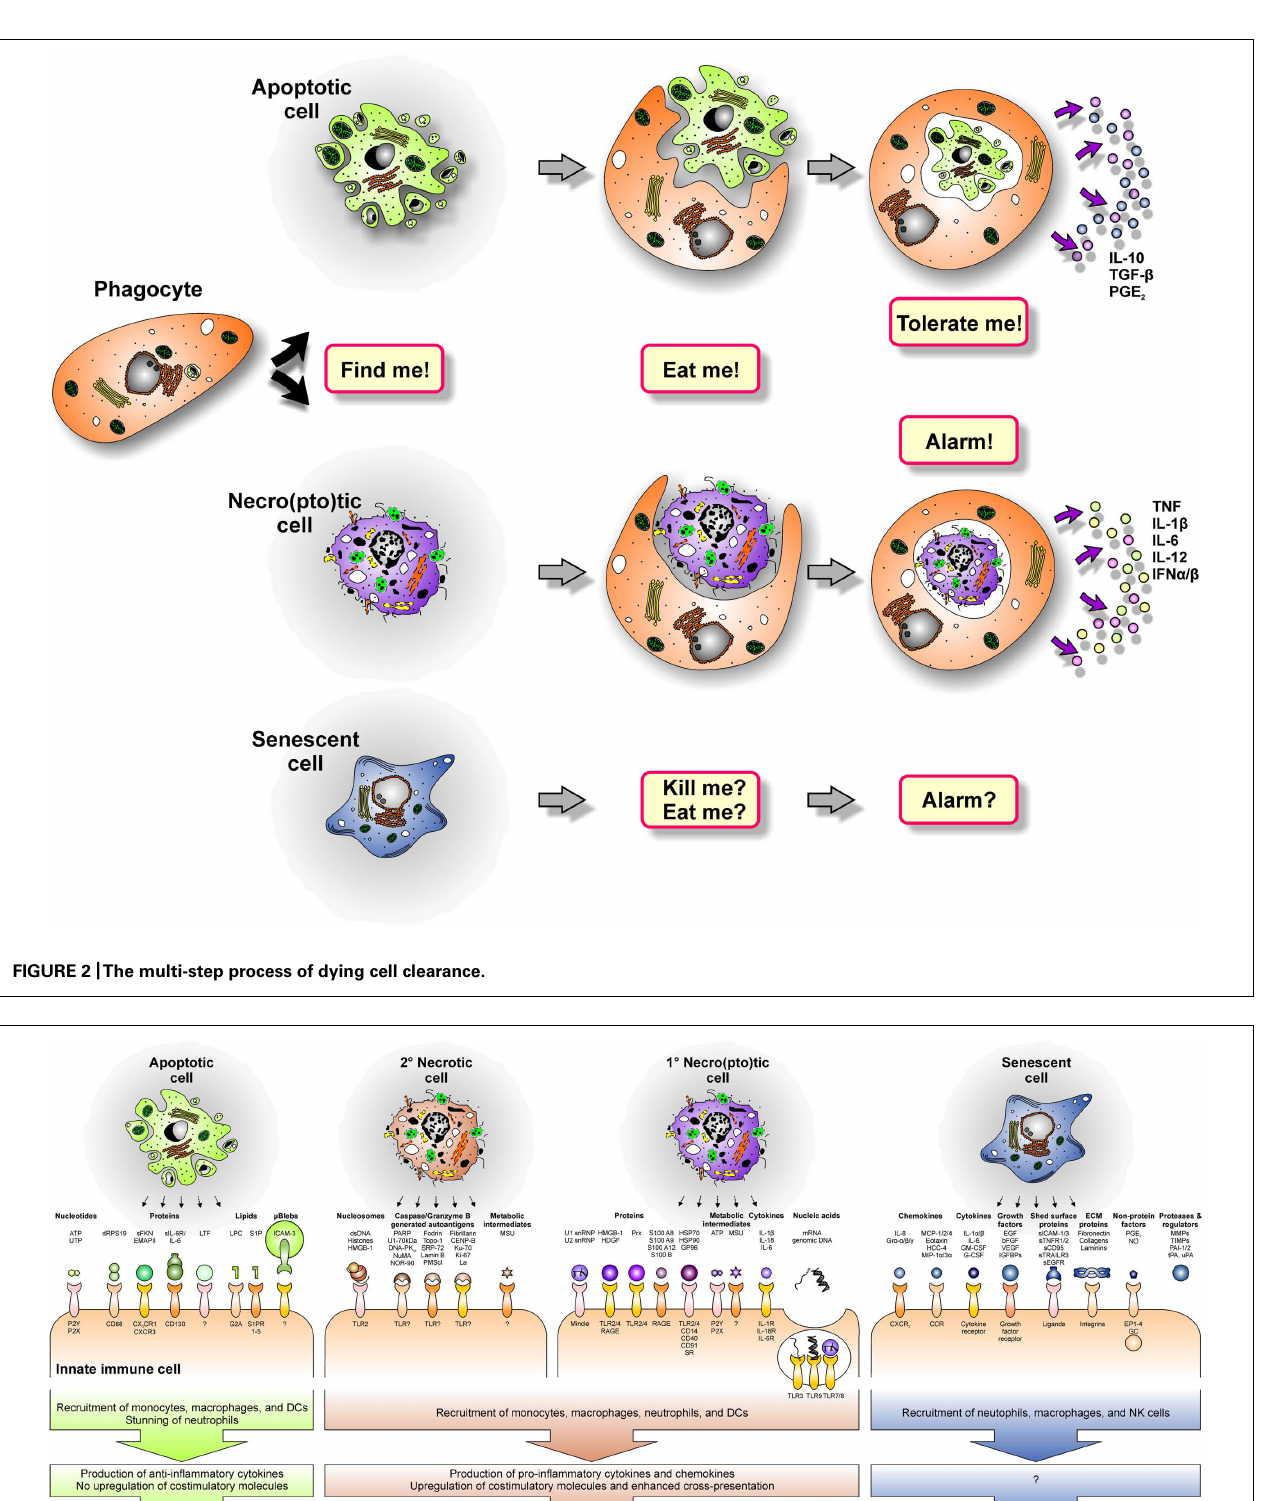
FIGURE 3 |The secretome and releasate of cells undergoing different forms of cell death and senescence recruit immune cells and skew the immune response toward tolerance induction or anti-tumor immunity.